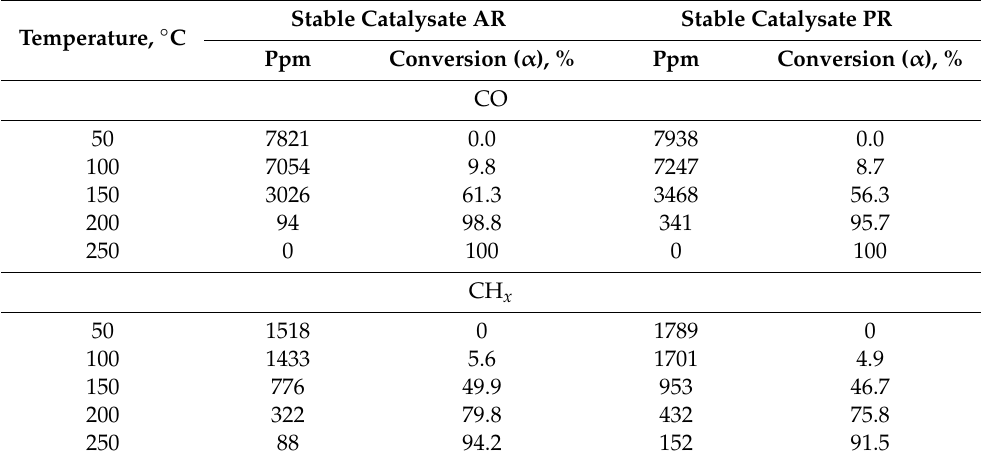
Table 7. Oxidation of CO and CH x during neutralization of the exhaust gases of an ICE over a 10% Co + 0.5% Pt / Al 2 O 3 catalyst. Stable Catalysate AR Stable Catalysate PR Temperature, ◦ C Ppm Conversion ( α ), %